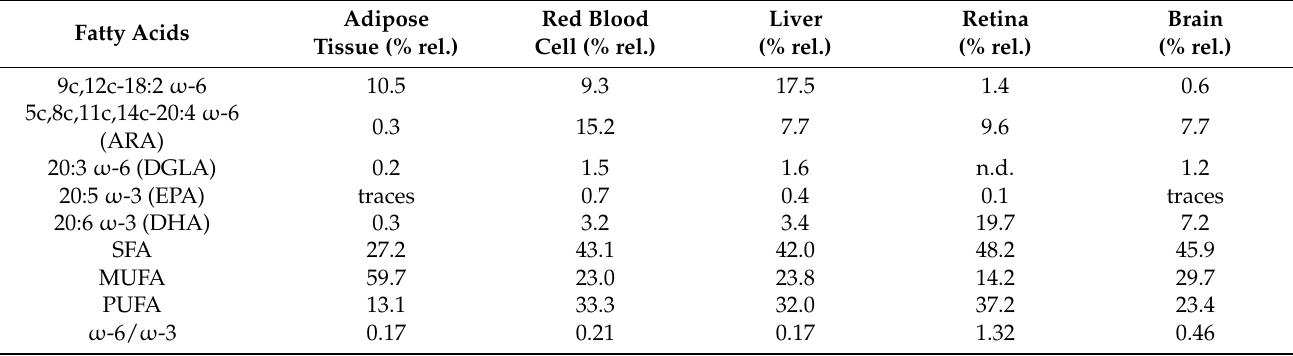
Table 1. Details of the fatty acid composition (% rel.) of membrane phospholipids in human tissues 1